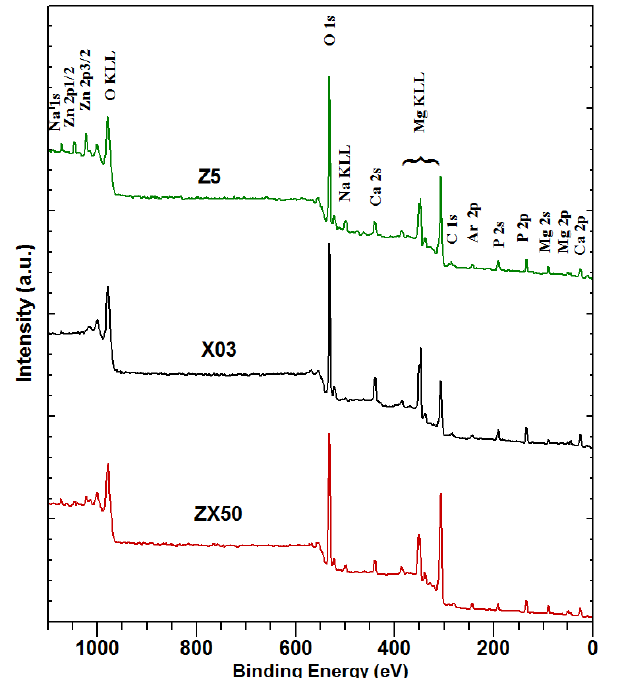
Figure 7. The survey XPS spectra of sputtered samples of ZX50, X03 and Z5 alloys after immersion in the SBF.